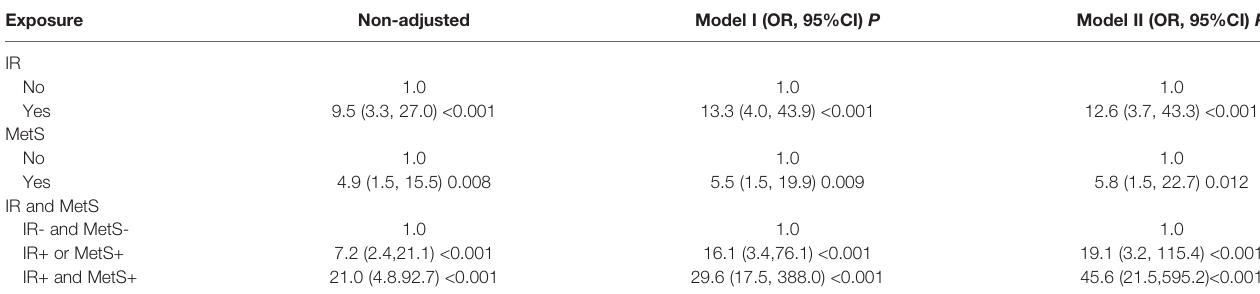
TABLE 3 | Logistic regression models evaluating the relationship between metabolic features and recurrence . Exposure